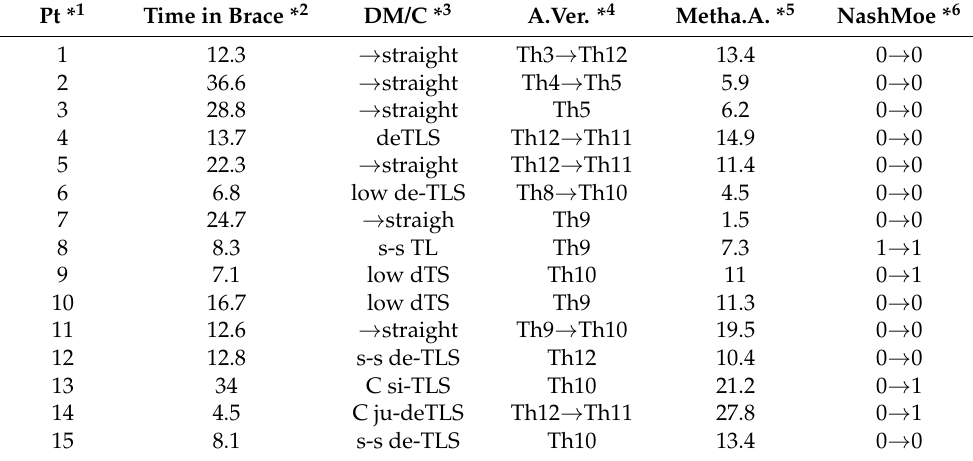
Table 3. Secondary radiographic parameters. * 1 Patient ID. * 2 Time in the brace (in months). * 3 changes in descriptive morphology/classification (straight = developed from initial curve straight, → = changed to, otherwise unchanged/Type of scoliosis (C, single curve; ju, juvenile; de, dextrokon- vex; si, sinistrokonvex; TS, thoracic; TLS, thoracolumbar; s-s, combined curve). * 4 Level of apex vertebrae for the primary curve ( → = changed to, otherwise unchanged). * 5 Difference in Metha angle at apex vertebra. * 6 change in Nash and Moe’s classification at apex vertebra for the primary curve ( → = changed to, otherwise unchanged). Pt *